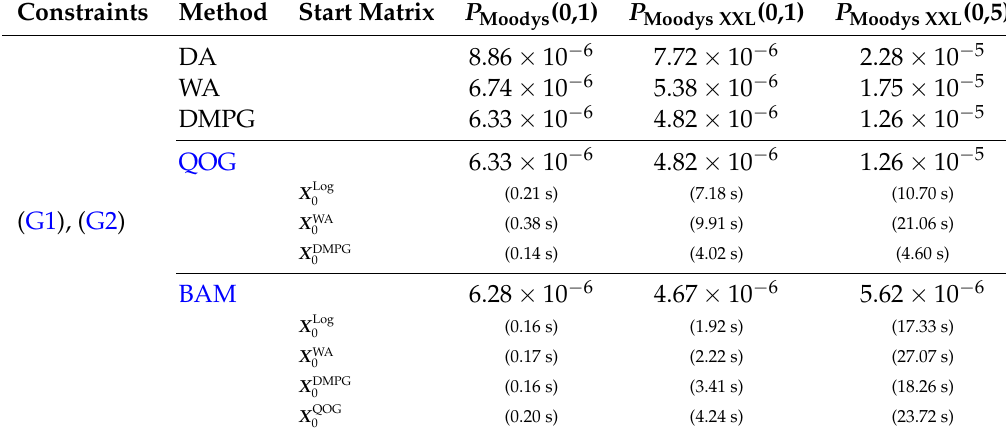
Table 1. Comparison of the regularization methods based on averaged Frobenius norm (QOG and BAM optimizations based on Constraints (G1) and (G2)), for given transition matrices from Moodys in Table